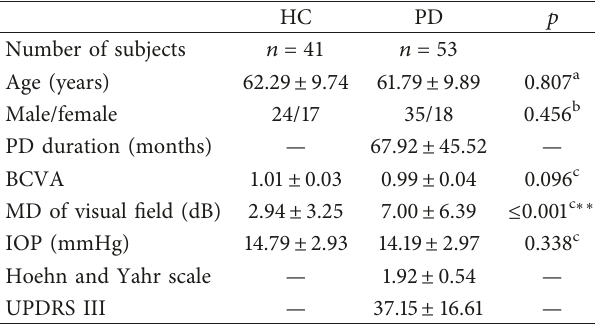
Table 1: Demographics, disease characteristics, and visual field of all participants.